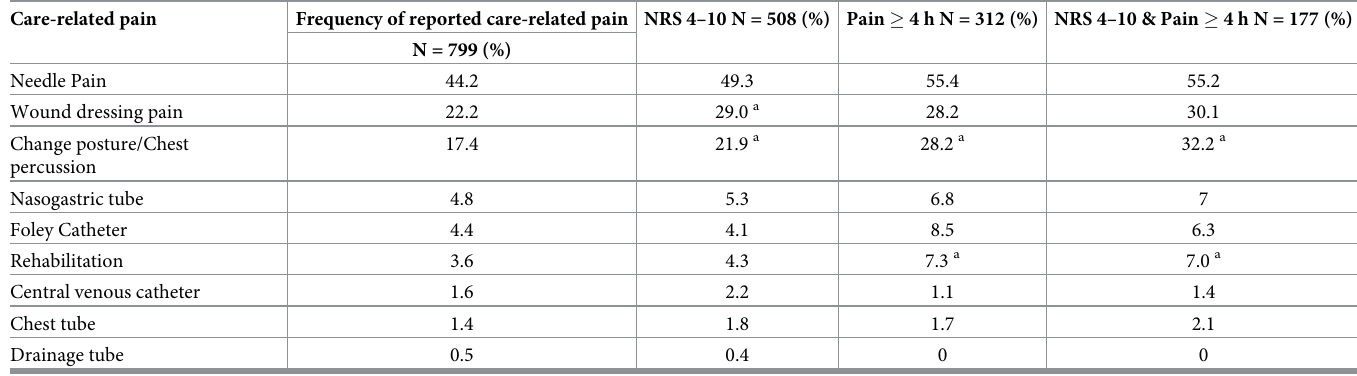
Table 3. Risk factors of moderate to severe pain, pain longer than 4 hours and both, in reported care-related pain. Care-related